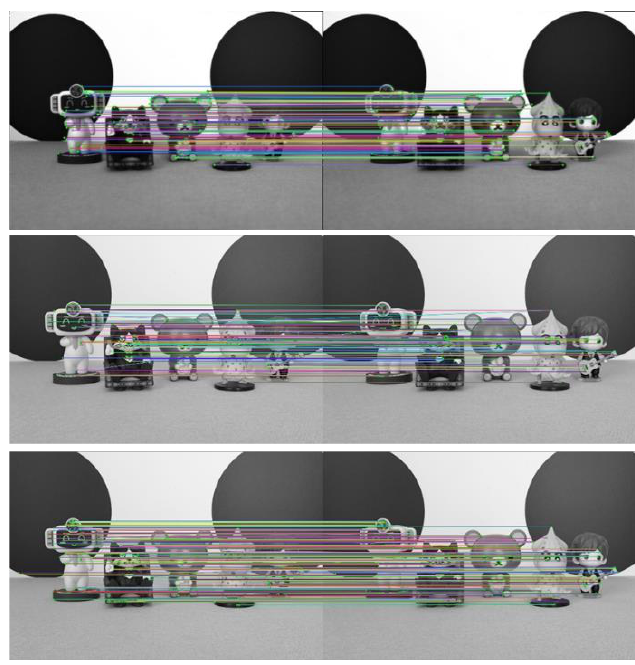
Figure 8. Scene 2 image feature point matching results.